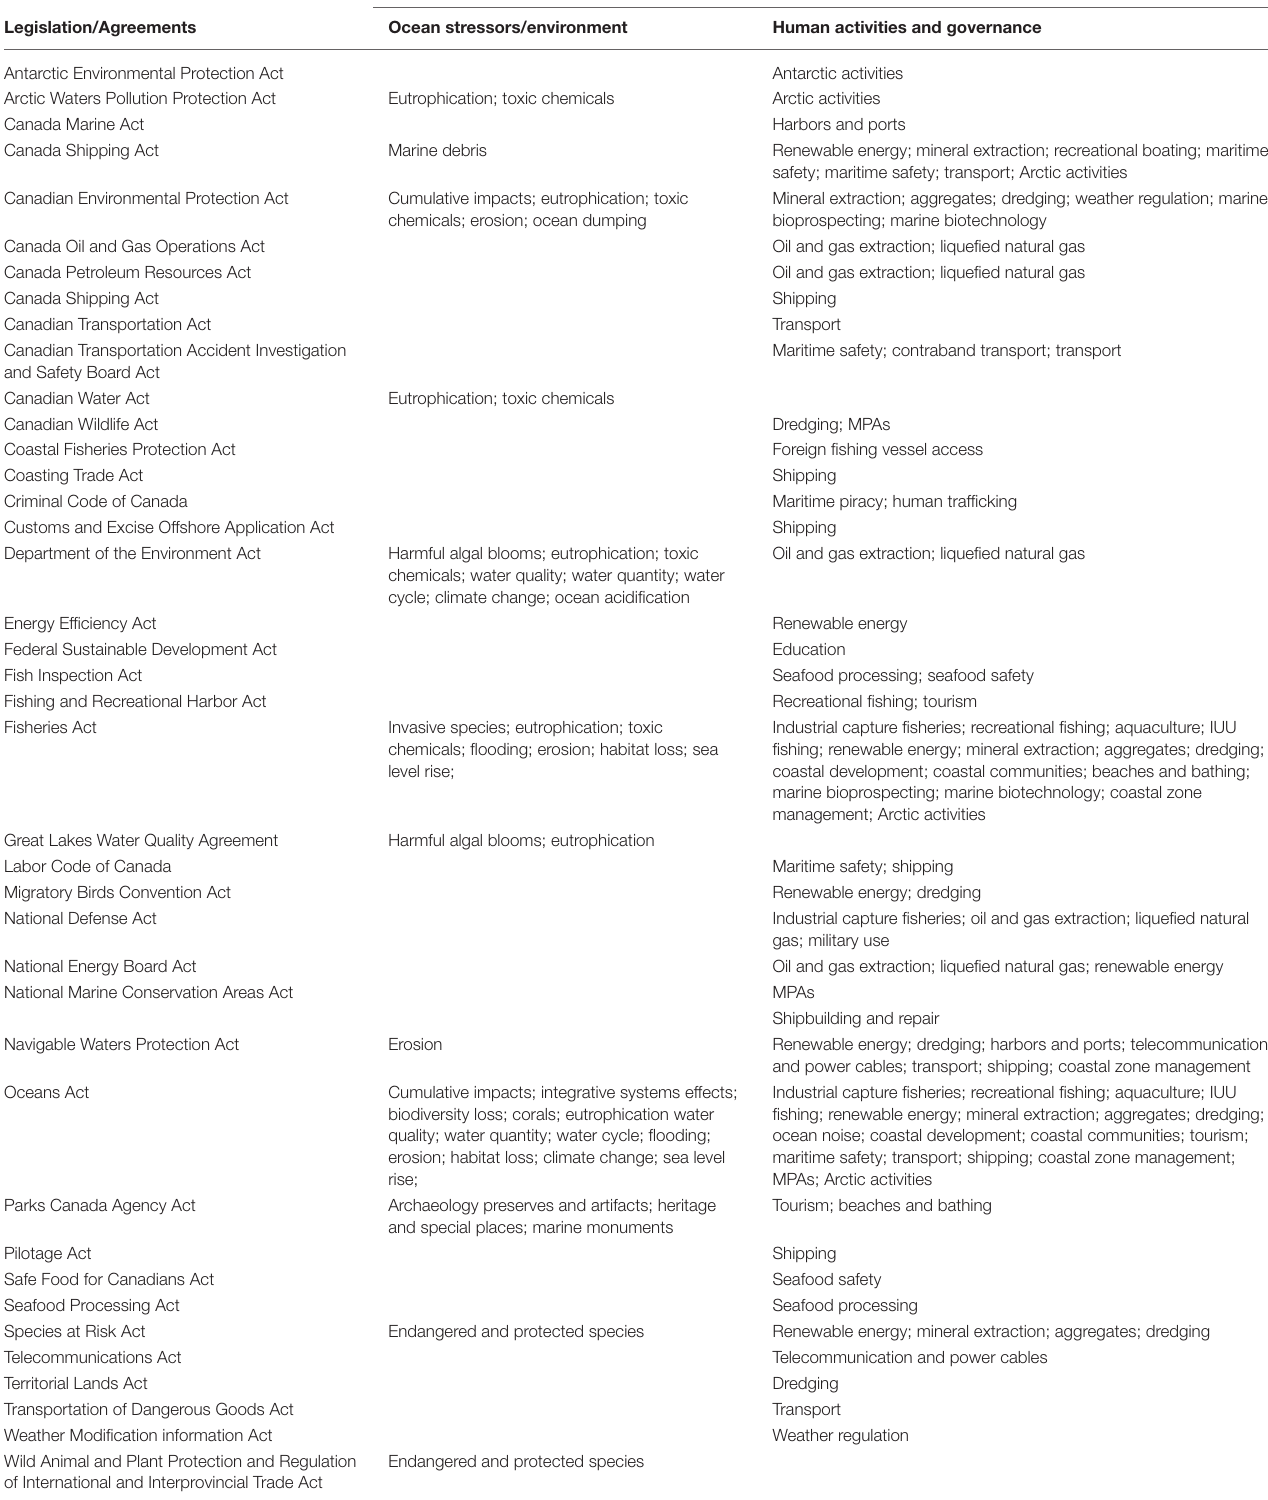
TABLE 2 | Canadian legislation potentially relevant for